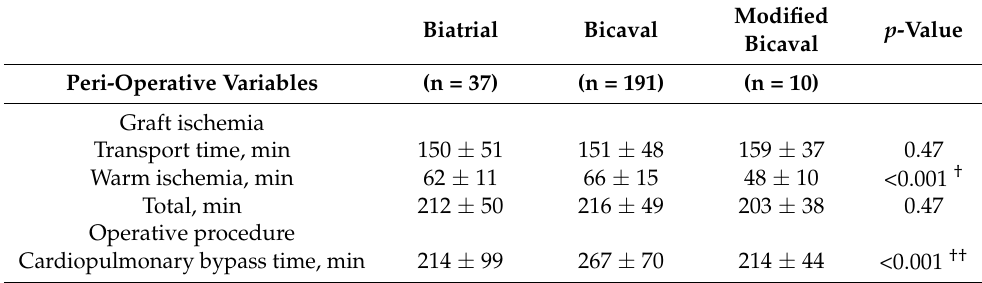
Table 3. Peri-procedural